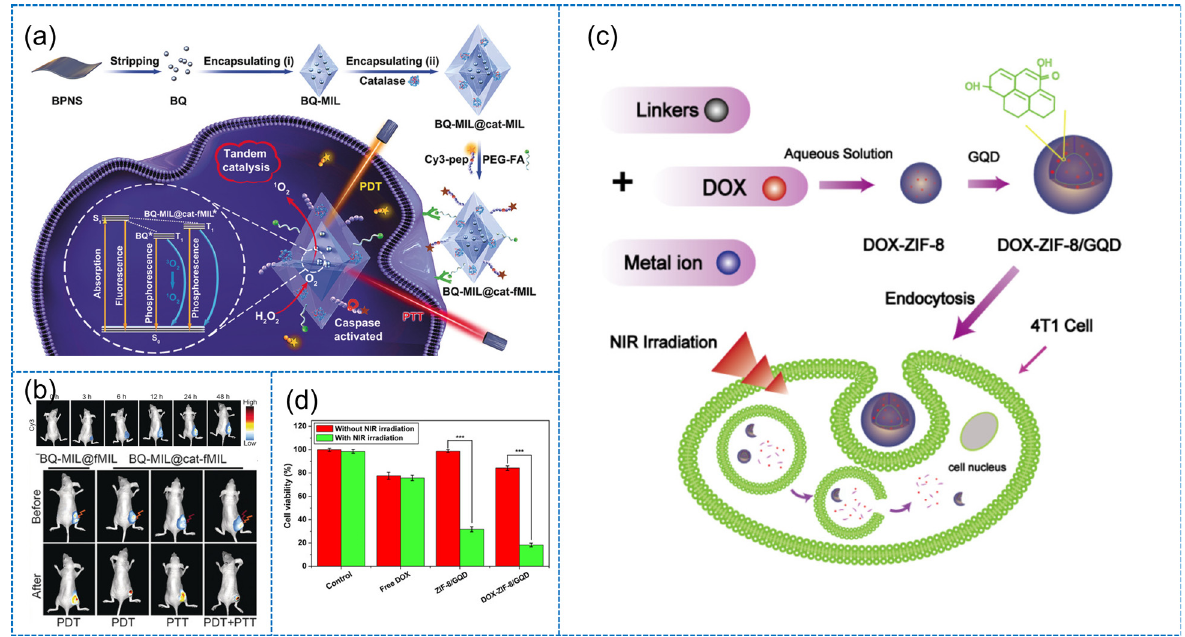
Figure 8: ( a ) Stepwise construction of BQ - hybridized MOF catalyst and action toward hypoxic tumor cell treatment. ( b ) After being inoculated with BQ - MIL@cat - fMIL, time - dependent in vivo fl uorescence images of a mouse carrying a subcutaneous HeLa tumor and after injection of BQ - MIL@cat - fMIL or BQ - MIL@fMIL in vivo fl uorescence imaging evaluated the treatment upshot on mice malignant cells [ 131 ] . ( c ) Schematic representation of the development of ZIF - 8/GQDs with the recapitulation of DOX. ( d ) After 8 h of incubation, cell viability study of 4T1 cells with and without free DOX, ZIF - 8/GQD, and DOX - ZIF - 8/GQD suspensions and deprived of 3 min NIR radiation [ 132 ]